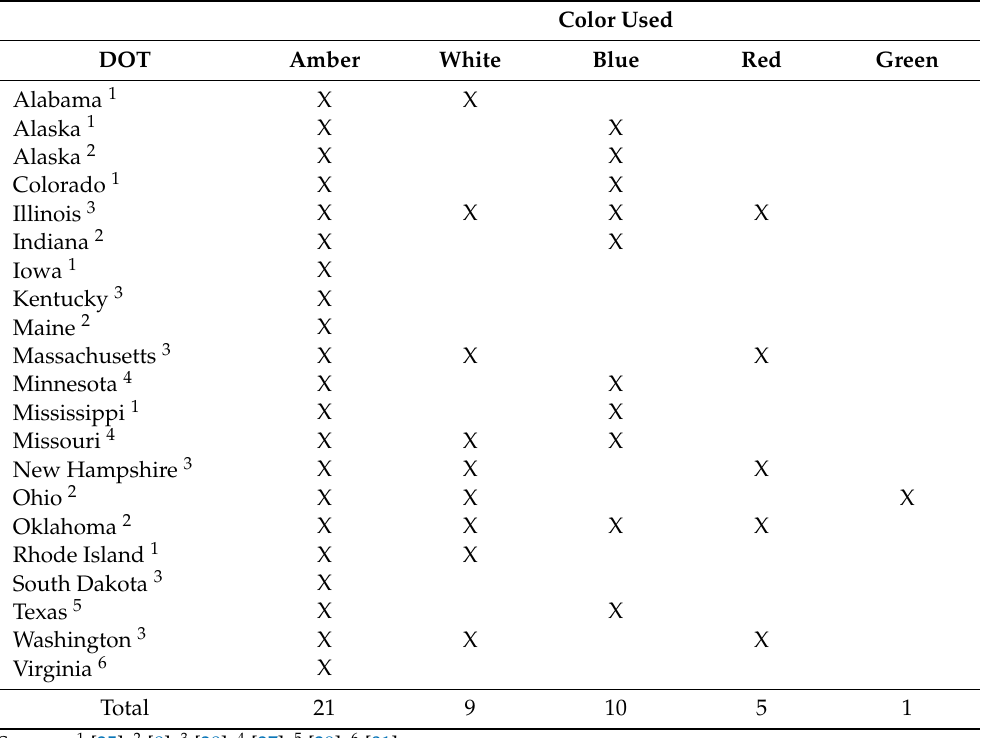
Table 6. Warning light colors used in various states. Color Used DOT Amber White Blue Red